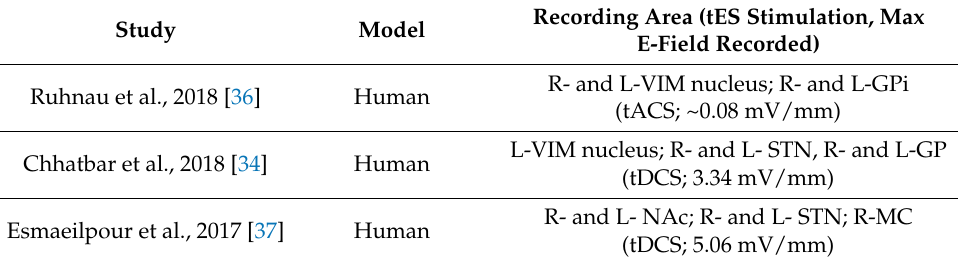
Table 1. Studies investigating electric fields in deep brain structures.